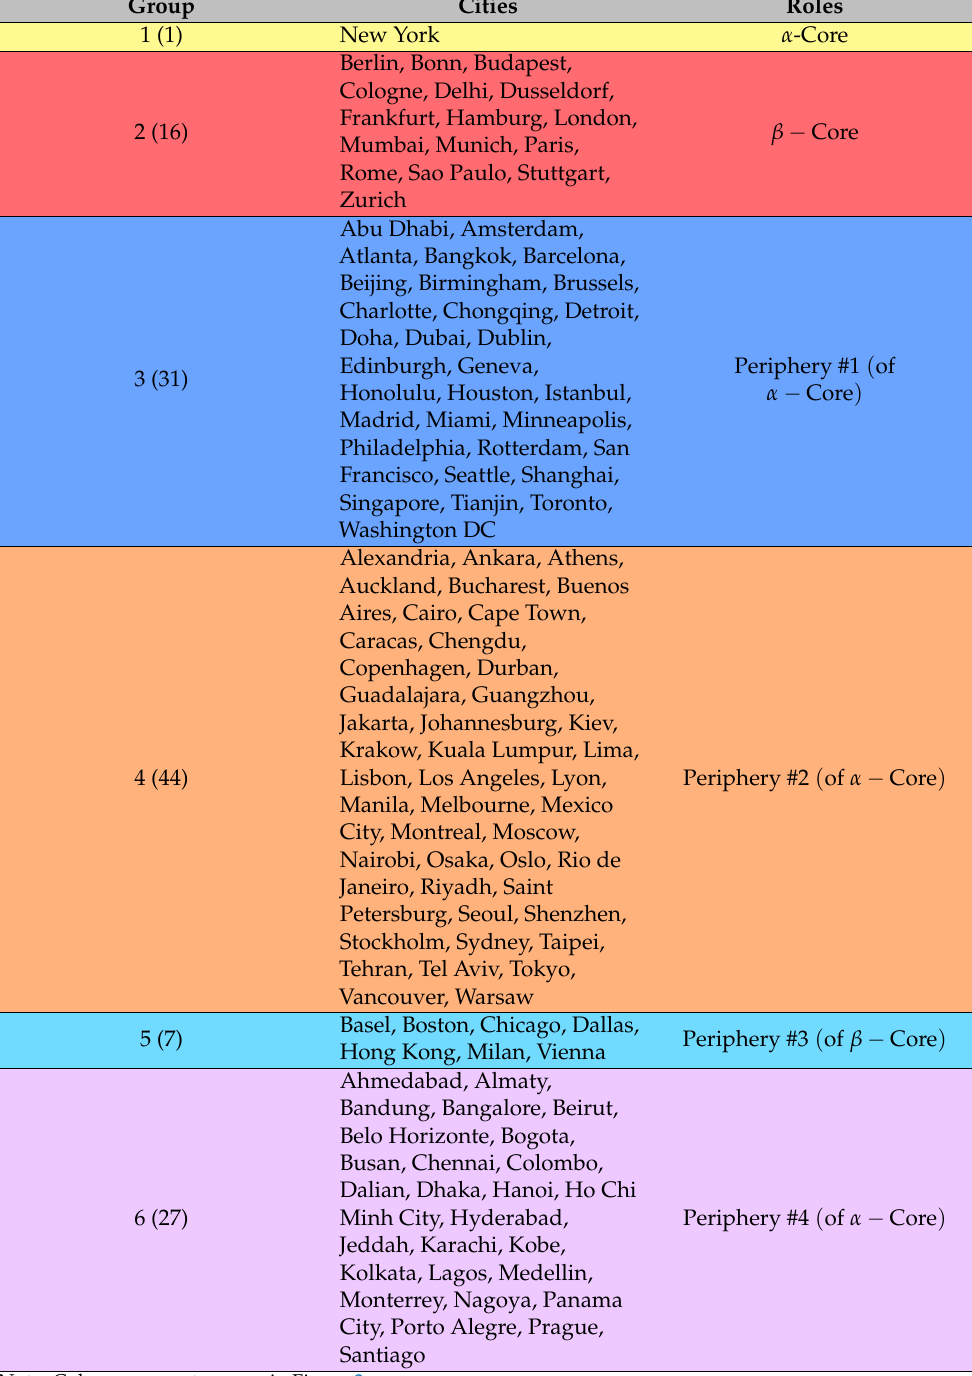
Note: Colors represent groups in Figure